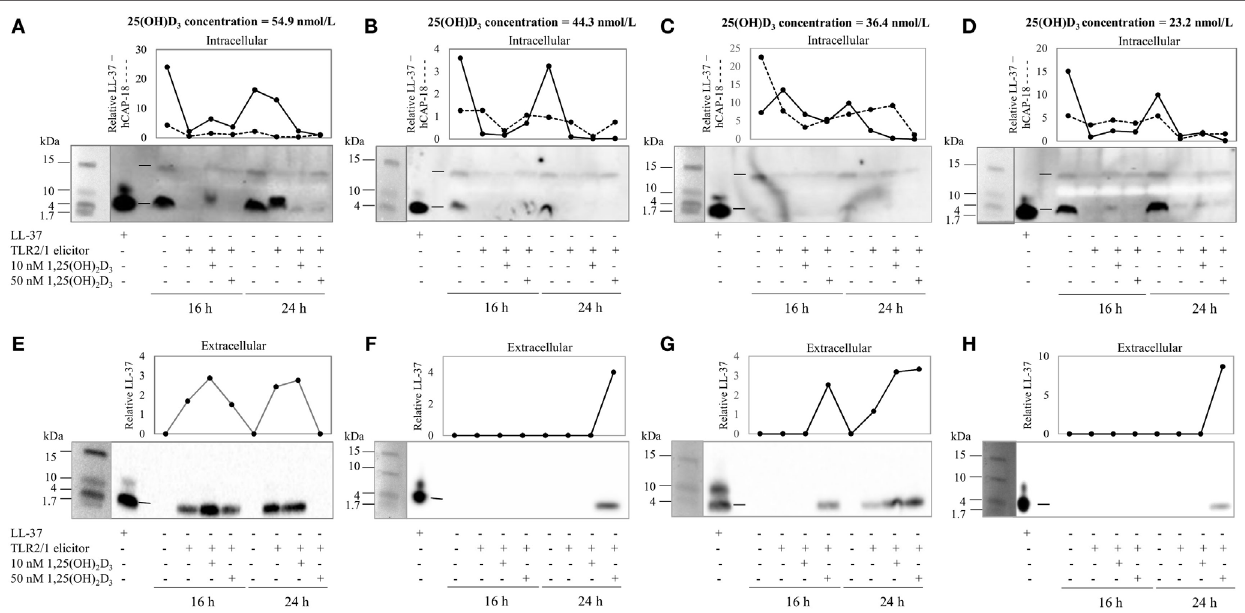
FigUre 7 | The rate of hCAP-18 processing and secretion is individual-specific and 1,25(OH) 2 D 3 -dependent. The Western blots and accompanying line graphs (densitometry results) show the relative levels of hCAP-18 (15 kDa) and LL-37 (4 kDa) in monocytes/macrophages [intracellular, (a–D) ] and LL-37 secreted into culture media [extracellular, (e–h) ] in response to toll-like receptor (TLR) 2/1 elicitation in the absence or presence 10 or 50 nM 1,25(OH) 2 D 3 at 16 h and 24 h. Four individuals from a study of healthy South Africans ( n = 20) are shown, representing Blacks and Whites of different 25(OH)D 3 status [ (a,e) : 25(OH)D 3 sufficient White; (B,F) : 25(OH)D 3 -deficient White; (c,g) : 25(OH)D 3 -deficient Black; and (D,h) : 25(OH)D 3 -deficient Black]. Relative protein or peptide level in monocytes/macrophages or culture media (enriched for proteins < 50 kDa through ultrafiltration) was quantified and normalized to total protein loaded (dotted line, cathelin; solid line, LL-37). Single dashes on blots, between lanes for LL-37 standard and control sample, indicate the position of hCAP-18 (15 kDa), without signaling peptide (3 kDa, not detected), and LL-37 (4 kDa) cleaved from cathelin (11 kDa, not